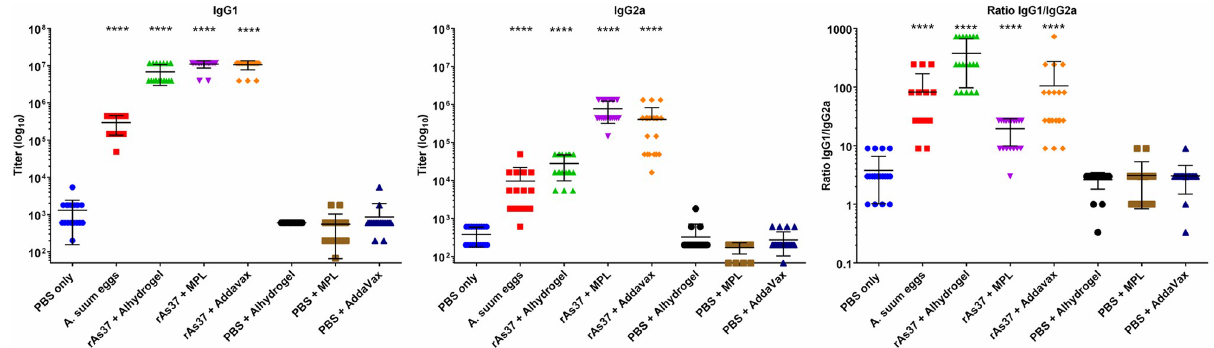
Fig 4. Anti-As37 IgG1and IgG2a titers (Log10) in sera of BALB/c mice immunized with rAS37 formulated with different adjuvants: Alhydrogel, MPL, and AddaVax, as measured by ELISA. Results are shown as means ± standard deviations and individual data points for each group (n = 15). The anti-As37 IgG1 and IgG2a titers were also measured in groups of mice infected with 1,000 A . suum infective eggs for three times. The anti-rAs37 IgG1/ IgG2a ratio in each group was also shown. ���� p < 0.0001.